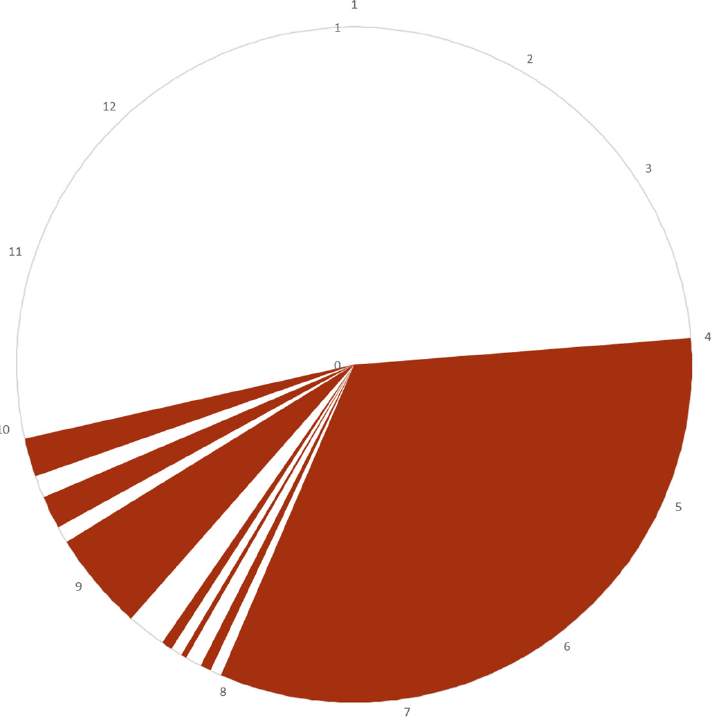
Figure 9. Days with a surplus of electricity production from PV over the demand of WDS during the year.